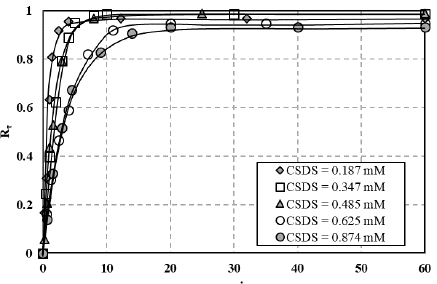
Figure A16. Changes in Al(III) temporary removal ratio during precipitate flotation from solution containing Al(III), Cu(II), and Zn(II) mixture—effect of collector concentration (c 0 = 2 mmol dm − 3 , pH = 8.7, u G = 1.51 mm s − 1 ).